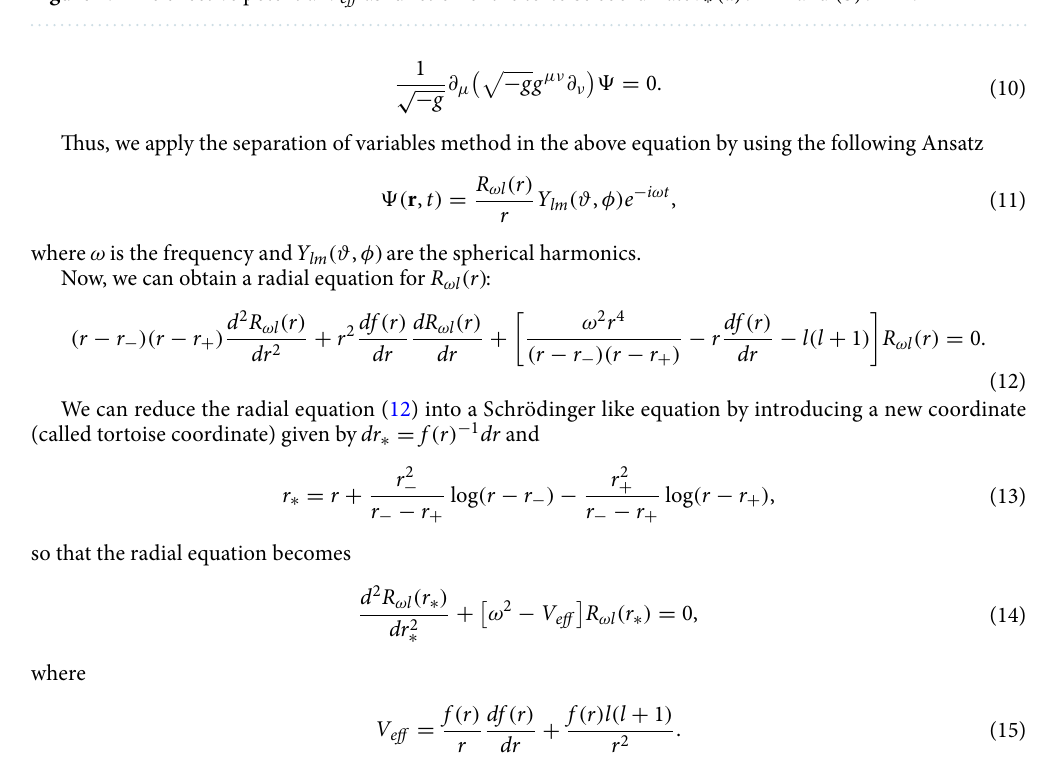
Figure 1. The effective potential V eff as function of the tortoise coordinate r